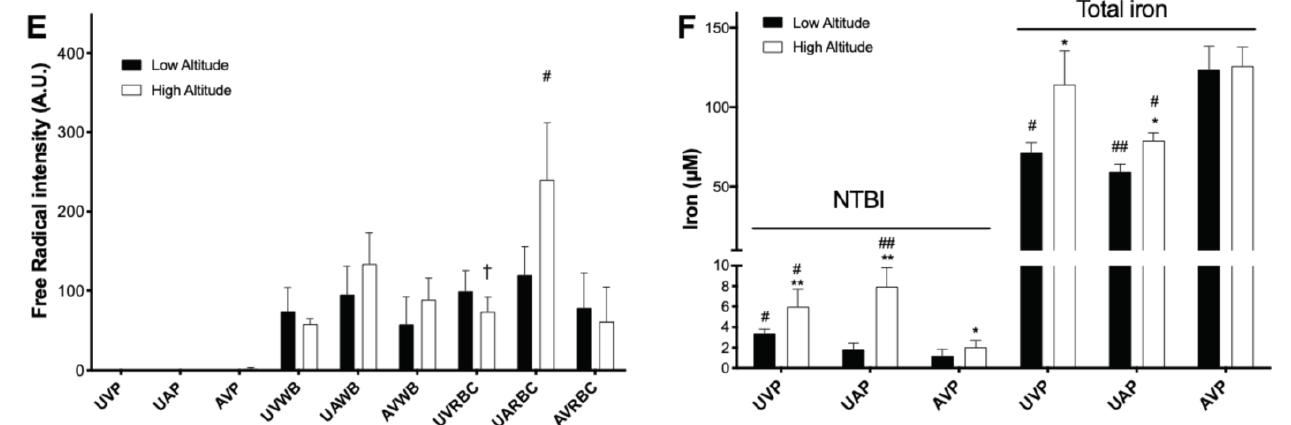
Figure 2. Metalloproteins, free radicals, and iron in blood from high and low altitude pregnant sheep. ( A – D ) Metalloproteins quantified from EPR spectra. ( A ) MetHb. ( B ) Transferrin. ( C ) Ferric heme proteins. ( D ) Ceruloplasmin. ( E ) Free radicals quantified from EPR spectra. ( F ) Plasma NTBI and total iron quantified with colorimetric methods. Because of the lack of standards, the intensity of the EPR signal of ferric heme proteins and free radicals are shown. UVP: umbilical vein plasma; UAP: umbilical artery plasma; AVP: adult (maternal) vein plasma; WB: whole blood; RBC: washed red blood cells. Two-way ANOVA with Tukey’s post-hoc tests for P, WB, or RBCs. * = p < 0.05 high vs. low altitude; † = p < 0.05 umbilical artery vs. vein; # = p < 0.05 fetus vs. mother. One symbol = p < 0.05, two symbols = p < 0.01.